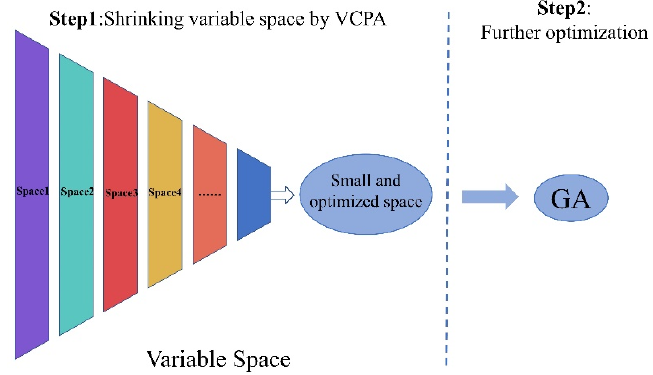
Figure 6. Two main steps of the VCPA-GA hybrid strategy.